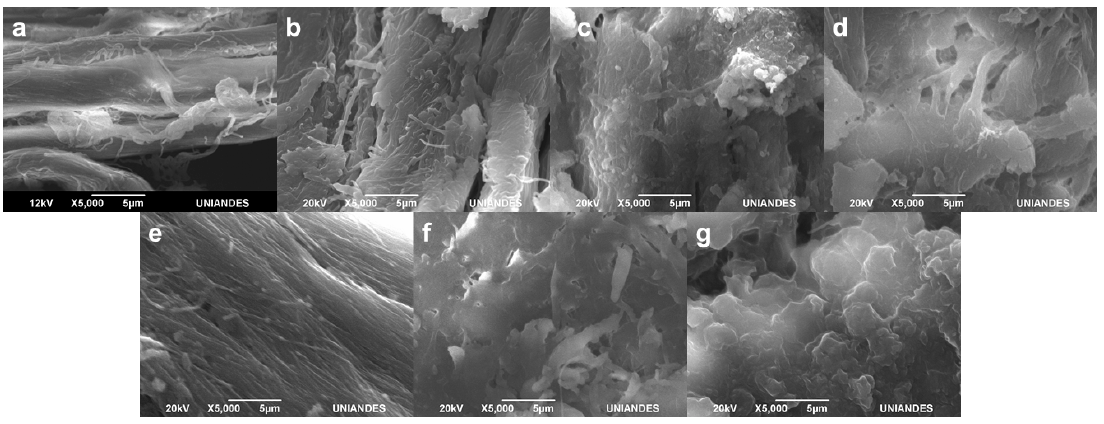
Figure 5. SEM photographs of ( a ) untreated leather, ( b ) APTES, ( c ) TEOS, ( d ) DODEC, ( e ) ( f ) TEOS + glu and ( g ) DODEC + APTES+glu, ( f ) TEOS+glu and ( g ) DODEC+glu.